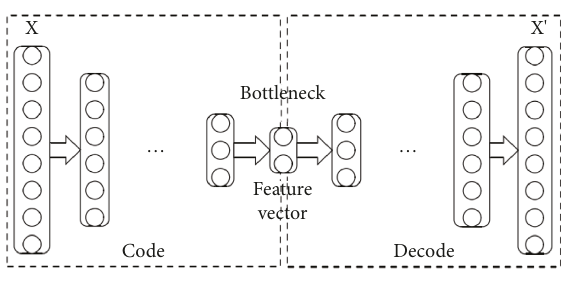
Figure 2: Stacked self-encoding network structure